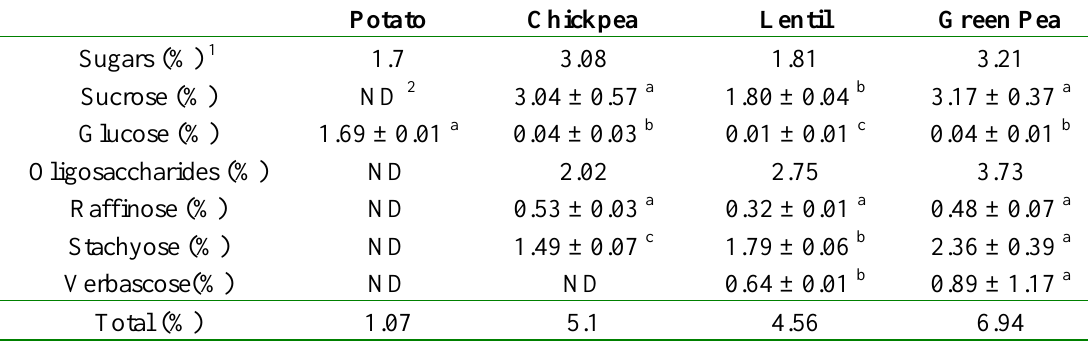
Table 3. Sugar and oligosaccharide composition of potato, chickpea, lentil and pea treatment powders, expressed as a percentage of the dried